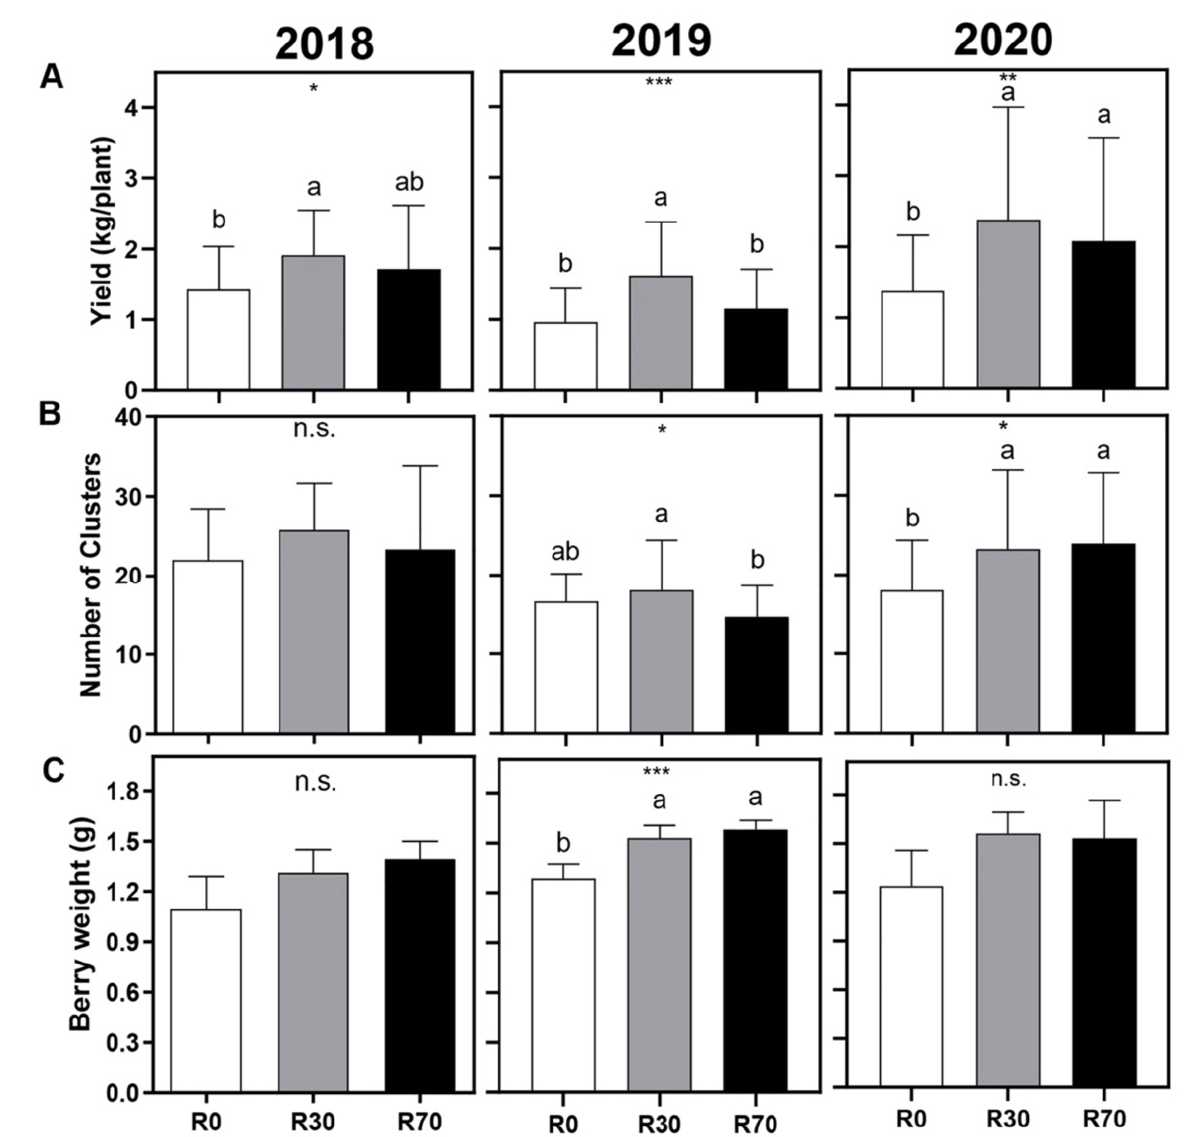
Figure 2. Effect of different irrigation conditions on ( A ) yield (kg/plant), ( B ) number of clusters per plant, and ( C ) berry weight, in 2018, 2019, and 2020 vintages of grapevine cv. ‘Touriga Nacional’. Irrigation conditions: R0 = non-irrigated plants; R30 = deficit irrigation corresponding to 30% of evapotranspiration; R70 = deficit irrigation corresponding to 70% of evapotranspiration. Results represent mean ± SD of four replicates. Asterisks indicate ANOVA statistical differences: * p ≤ 0.05; ** p ≤ 0.01; *** p ≤ 0.001; n.s. = non-significant. Lowercase letters indicate differences between treat- ments.